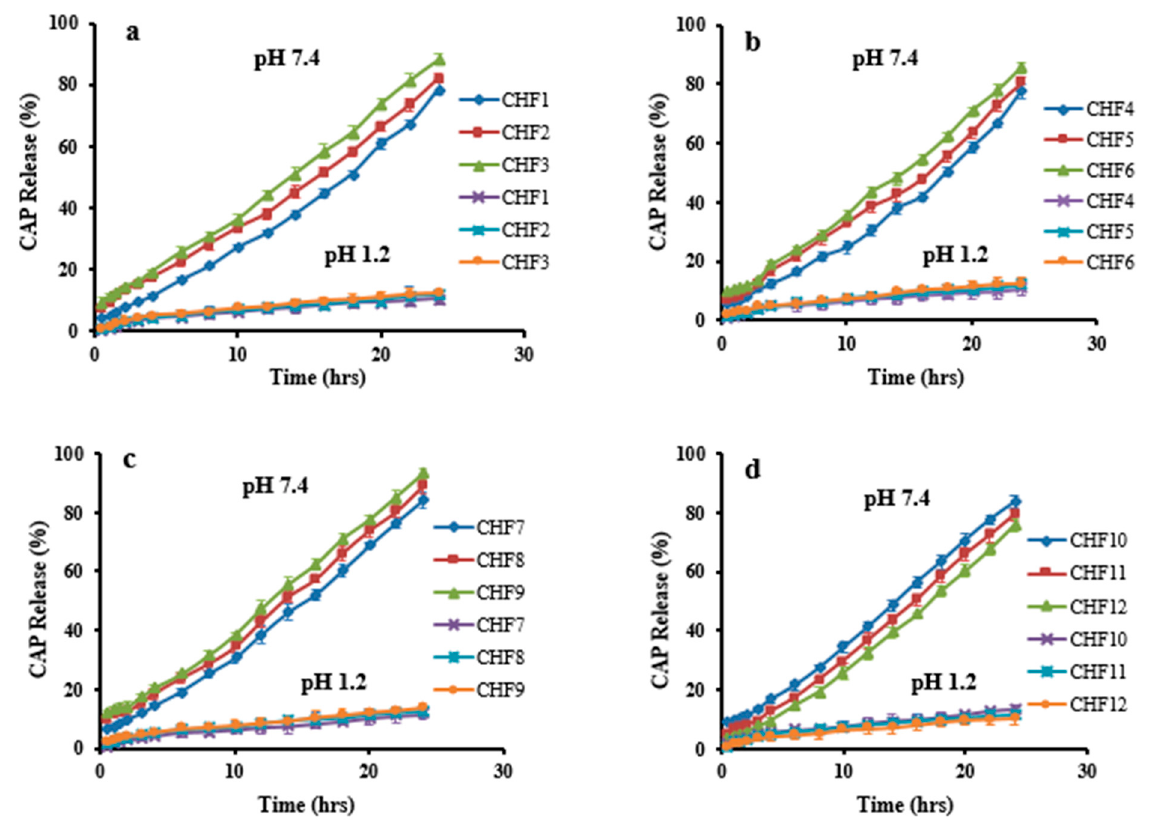
Figure 10. CAP release profile at pH 1.2 and pH 7.4. Effect of concentration of ( a ) chitosan, ( b ) fenugreek, ( c ) MAA, and ( d ) MBA on CAP release.